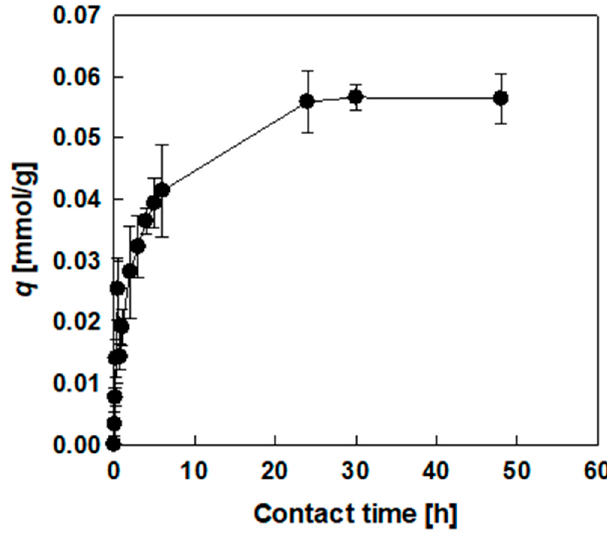
Figure 3. Effect of contact time on copper adsorption on amidoxime-chitosan hydrogels (gel dosage: 0.2 g, agitation speed: 100 rpm, temperature: 30 °C).